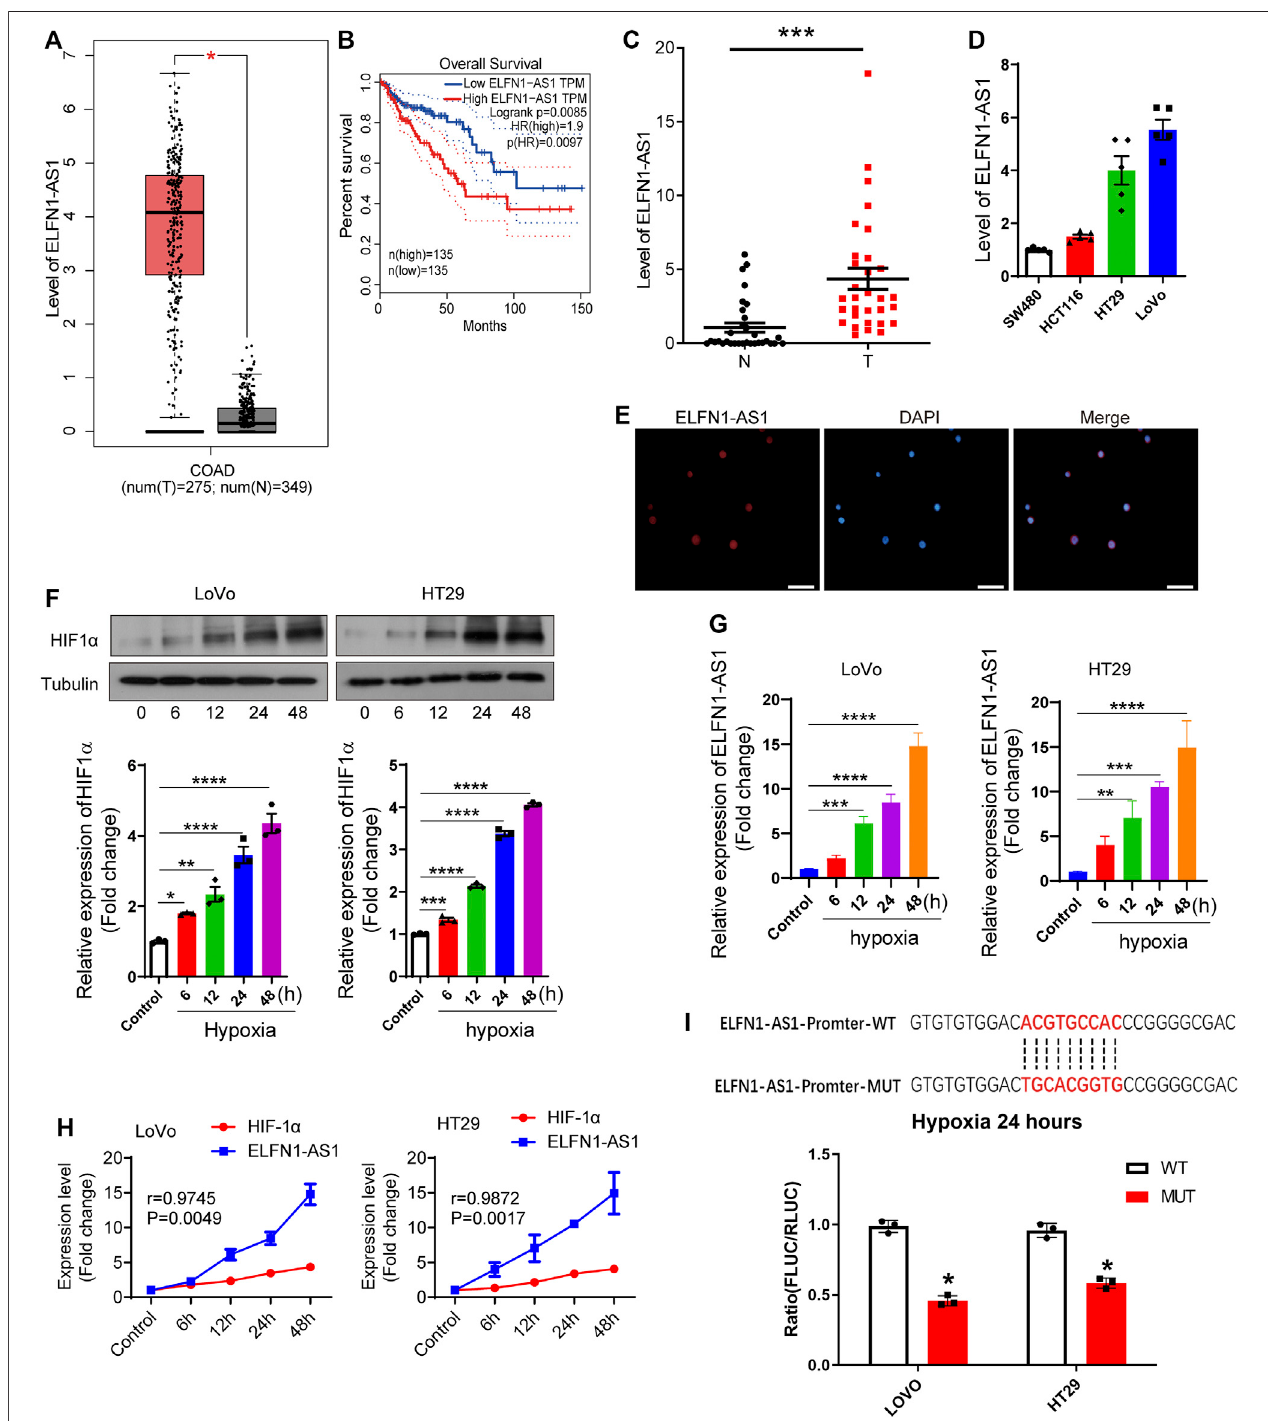
FIGURE1| HypoxiainducesoverexpressionofELFN1-AS1incoloncancer. (A) ExpressionlevelofELFN1-AS1incolonadenocarcinoma(COAD)wasanalyzedon the TCGA database (GEPIA). Compared with the normal tissues ( n = 349), ELFN1-AS1 was markedly upregulated in COAD tissues ( n = 275) ( p < 0.01). The method for differential analysis isone-way ANOVA. (B) Prognosis value of ELFN1-AS1in COAD was analyzed on the TCGA database (GEPIA). The COAD tissues were divided into two groups (low ELFN1-AS1 and high ELFN1-AS1 groups) at a 50% cutoff. Overall survival analysis was performed using the Log-rank test, a.k.a the Mantel – Cox test, for the hypothesis test. (C) qRT-PCR was performed to detect the expression of ELFN1-AS1 in 32 pairs of clinical tissues of colon cancer collected from local hospitals. Actin was used as an internal control. A paired t -test was used to compare 32 pairs of clinical tissues. (D) qRT-PCR was used to determine the ELFN1-AS1 level in four human colon cancer cell lines, HCT116, SW480, HT29, and LoVo. (E) Expression and distribution of ELFN1-AS1 in HT29 cells were analyzed by FISH. The